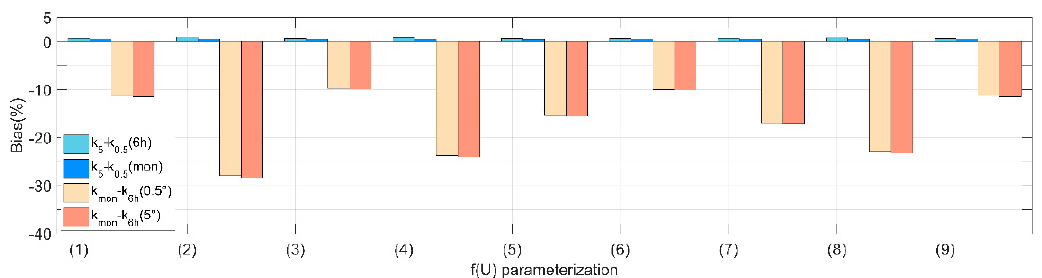
Figure 2. Bias in k of CO 2 due to wind speeds at varying spatial resolutions (0.5 ◦ × 0.5 ◦ and 5 ◦ × 5 ◦ ) for 6-hourly and monthly gas transfer velocity (k), and temporal bias in k (6 hourly and monthly) at the spatial resolution of 0.5 ◦ × 0.5 ◦ and 5 ◦ × 5 ◦ . The k mon and k 6h are gas transfer velocities averaged over all k values estimated from monthly and 6-hourly wind speed records, respectively. k 5 ◦ and k 0.5 ◦ are gas transfer velocities averaged over all k values estimated from 5 ◦ and 0.5 ◦ wind speed, respectively. The bias is estimated as (cid:52) k*100/k 6h,0.5 ◦ (k 6h,0.5 ◦ is k at the resolution of 6-hourly and 0.5 ◦ × 0.5 ◦